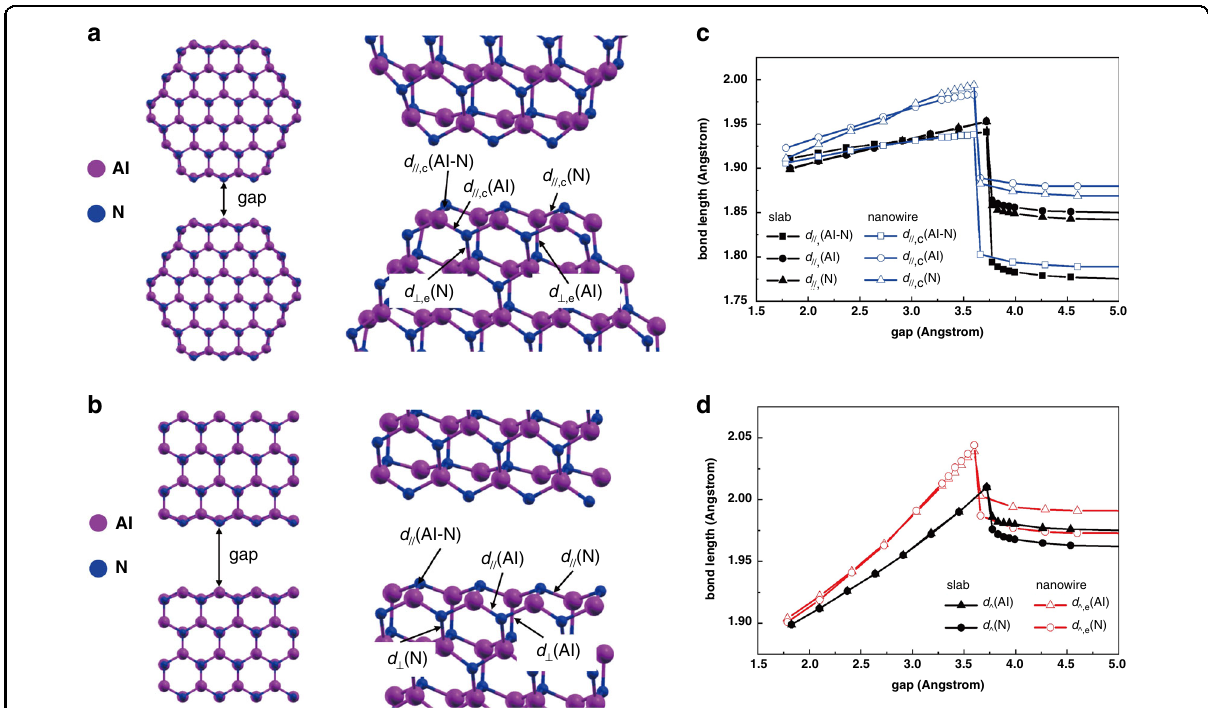
Fig. 4 DFT calculations of the coalescence between two AlN (1 1 00) surfaces. a Schematic plot of the coalescence between two AlN nanowires and the surface bond lengths. b Schematic plot of the coalescence between two in fi nite AlN surfaces and the surface bond lengths. d // (Al-N) is the bond length of the Al-N bond formed by the surface Al and N atoms parallel to the surface, d // (Al) is the bond length of the parallel Al-N bond formed by the surface Al and subsurface N atom, an d d // (N) is the bond length of the parallel Al-N bond formed by the surface N and subsurface Al atom. The notions for perpendicular bonds are similar. The subscripts e and c denote the bonds of the nanowire on the edge and near the corner, respectively. c The variation of the parallel bond lengths of nanowire and in fi nite surface as a function of the separation gap. d The variation of the perpendicular bond lengths of nanowire and in fi nite surfaces as a function of the separation